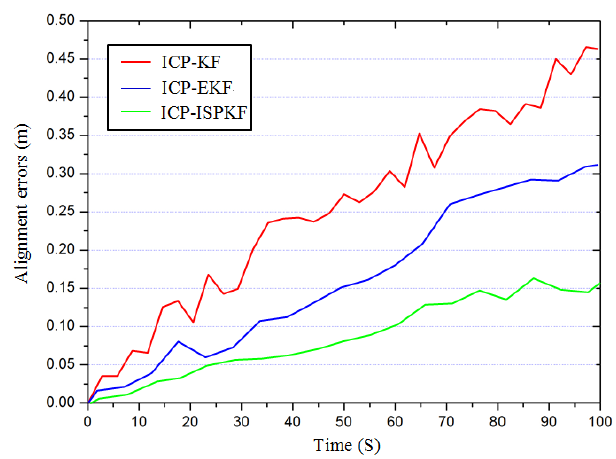
Figure 7. Time delay calibration using ICP-KF, ICP-EKF and ICP- ISPKF for LiDAR-IMU.